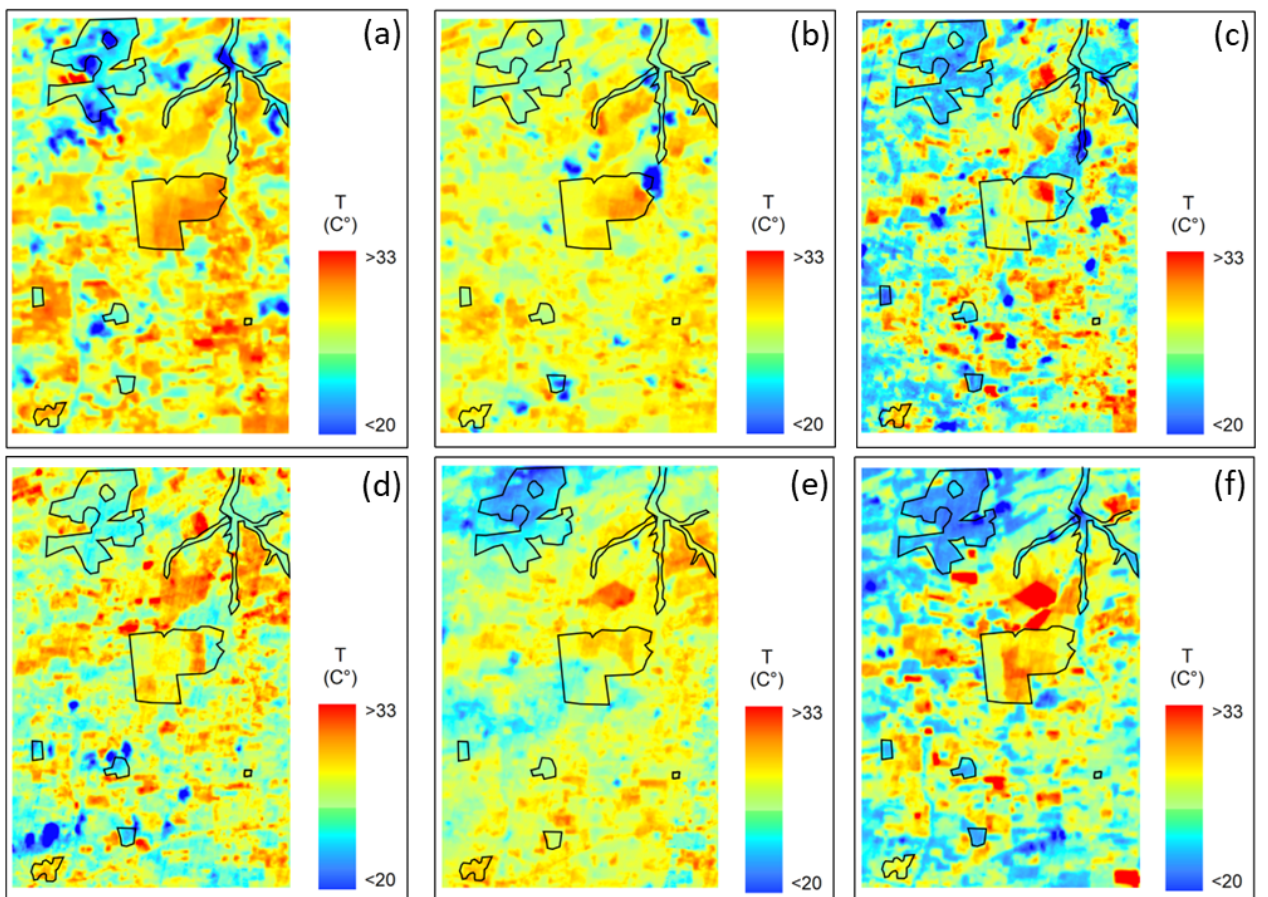
Figure 7. Temporal distribution of the variable surface temperature (T) on 20 November 2017 ( a ),